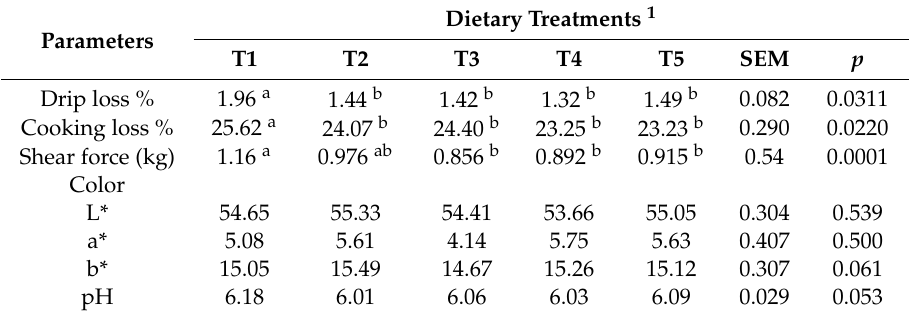
Table 3. Effects of inorganic selenium and different sources of bacterial selenoprotein on meat drip loss, cooking loss, shear force, color, and meat pH in broiler chickens Parameters